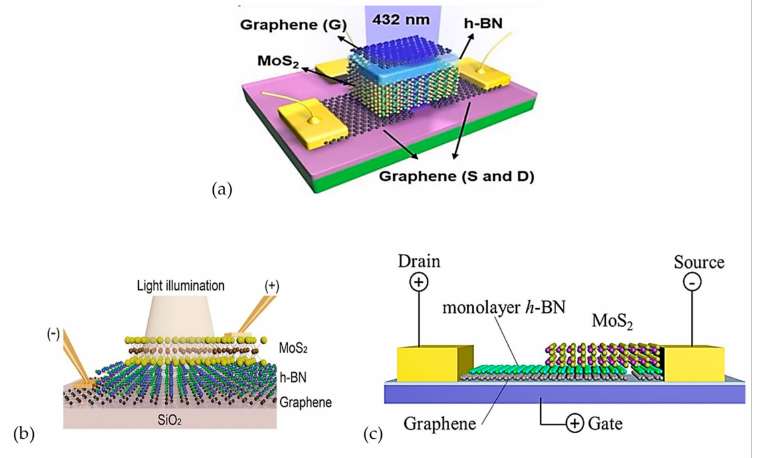
Figure 5. Photodetector architecture with lateral heterostructure of ( a ) graphene/MoS 2 /graphene (Reprinted with permission from [19], American Chemical Society, 2020) and vertical heterostructure of ( b ) monolayer MoS 2 /h-BN/graphene (Reprinted with permission from [54], American Chemical Society, 2016), and ( c ) multilayer MoS 2 /h-BN/graphene (Reprinted from [10], with permission from Elsevier,